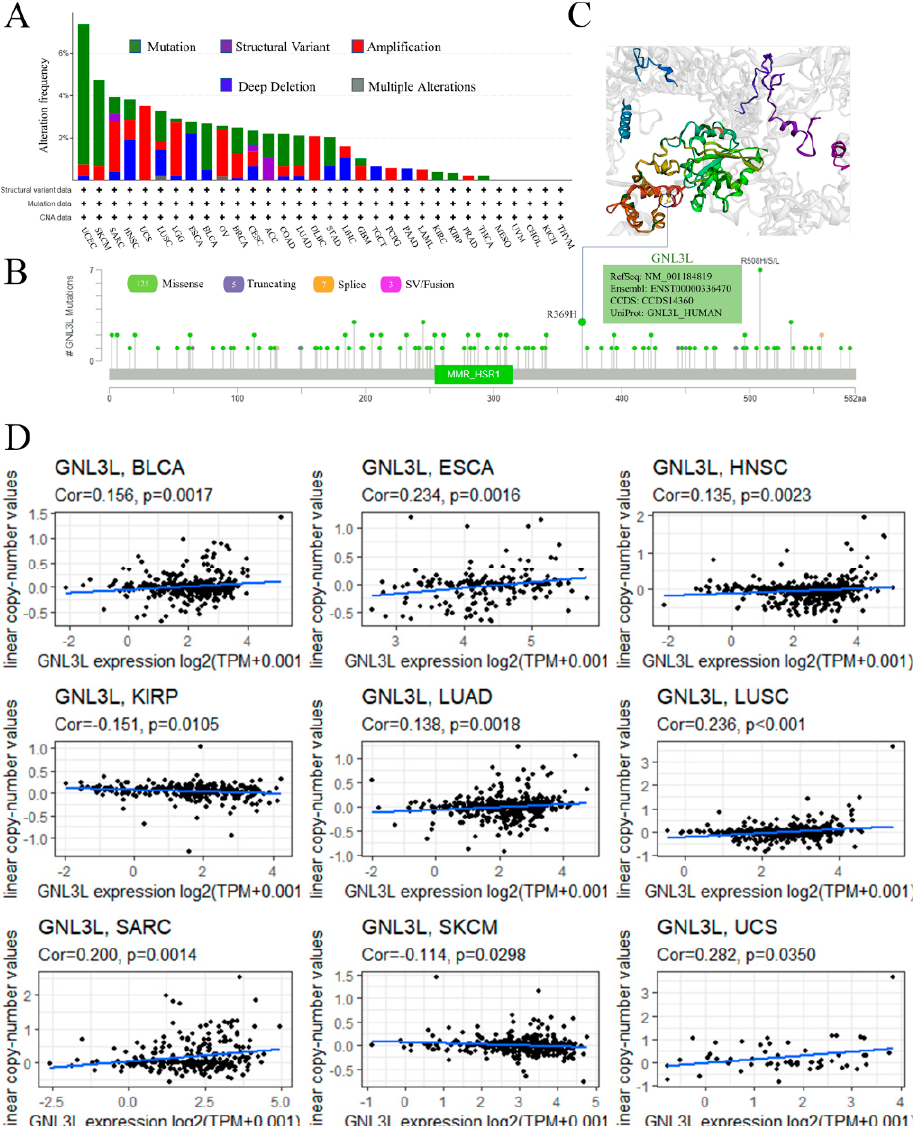
Figure 4. Genetic variation and mutation status of GNL3L. ( A , B ) show the mutation type and mutation frequency of GNL3L based on the cBioPortal database. ( C ) Mutation site R369H in the GNL3L 3D structure. ( D ) The correlation between GNL3L expression and the relative linear copy values of BLCA, ESCA, HNSC, LUAD, LUSC, SARC, UCS, KIRP, and SKCM was significant.